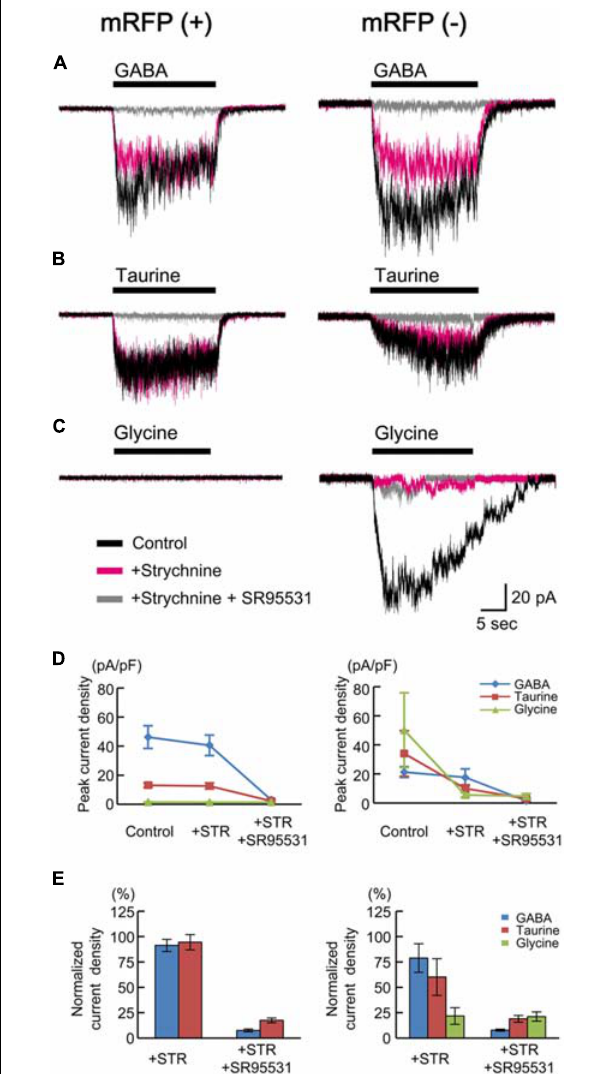
FIGURE 5 | GABA-, taurine-, and glycine-evoked currents in RFP-positive and -negative cells in GAD67 + / + fetuses. Typical traces of the currents evoked by the applications of 10 μ M GABA (A) , 10 mM taurine (B) , and 3 mM glycine (C) in RFP-positive (left panels) and RFP-negative (right panels) cells are shown. Black traces indicate the currents in the absence of blockers; red traces are the currents obtained after the application of 10 μ M strychnine through bath perfusion in the same cells; and gray traces are the currents recorded after the further addition of 10 μ M SR95531 to the bath solution. V H was − 60 mV. (D) The means ± SEMs of the peak current densities of the agonist-evoked currents in RFP-positive (left panel) and RFP-negative (right panel) cells in the absence and presence of strychnine (STR) and after the addition of SR95531 are plotted. (E) Effects of blockers on agonist-evoked currents.The peak current densities in the absence of blockers were normalized to 100%.